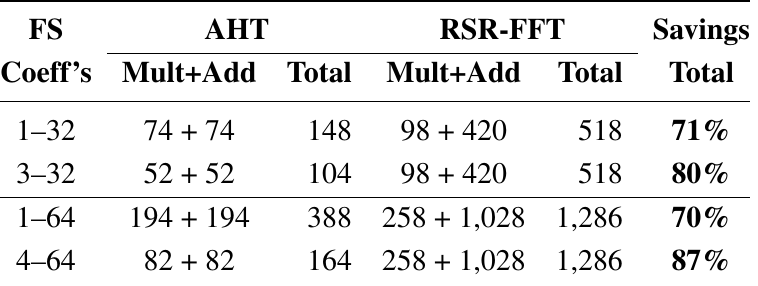
Table 1. Comparison of digital real-valued operations to compute Fouri ´ er series coefficients from the Analog Harmonic Transform (AHT) back-substitution ( M = 32 , 64 ) or real-input Fast Fouri´er Transform (FFT) algorithm ( N = 64 , 128